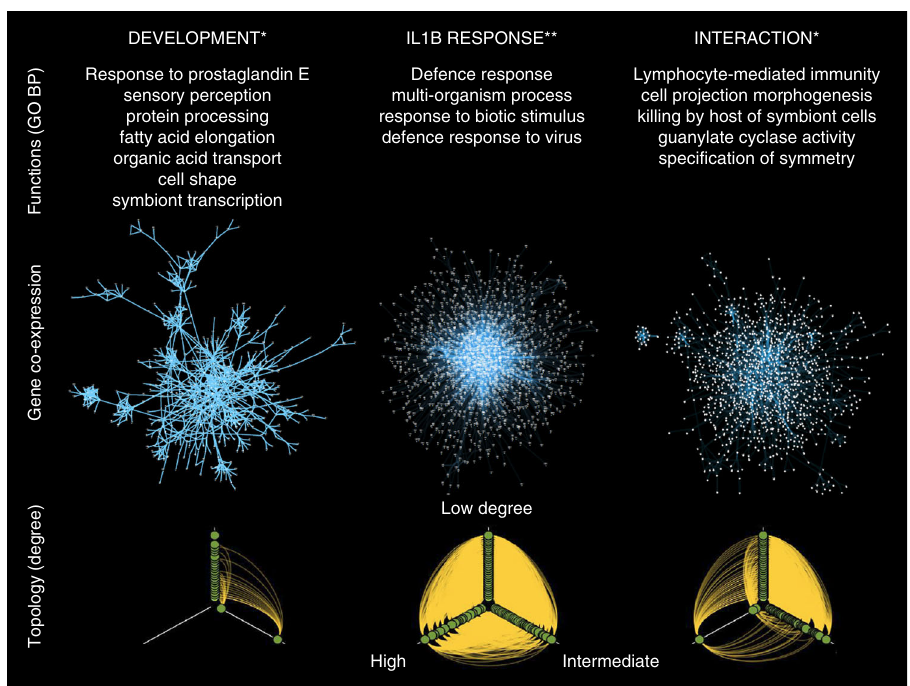
Fig. 2 Gene co-expression networks for three responses. Development, IL1B and interaction. Top : summary of functional annotation. Hypergeometric test, * = nominal p < 0.05, ** = adjusted p < 0.05. Middle : Gene co-expression networks; nodes = genes, edges = partial correlations, local FDR = 1x10 − 13 . Bottom : Hiveplots for each network illustrating differences in topology between responses, where nodes are arranged on axes according to their degree; axes range clockwise from top: degree < 30, 30 ≤ degree ≤ 80, degree x > 80